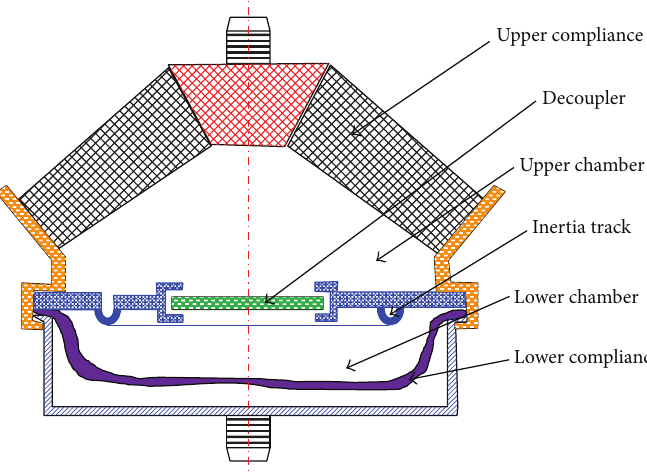
Figure 1: Cross section of conventional hydraulic mount.